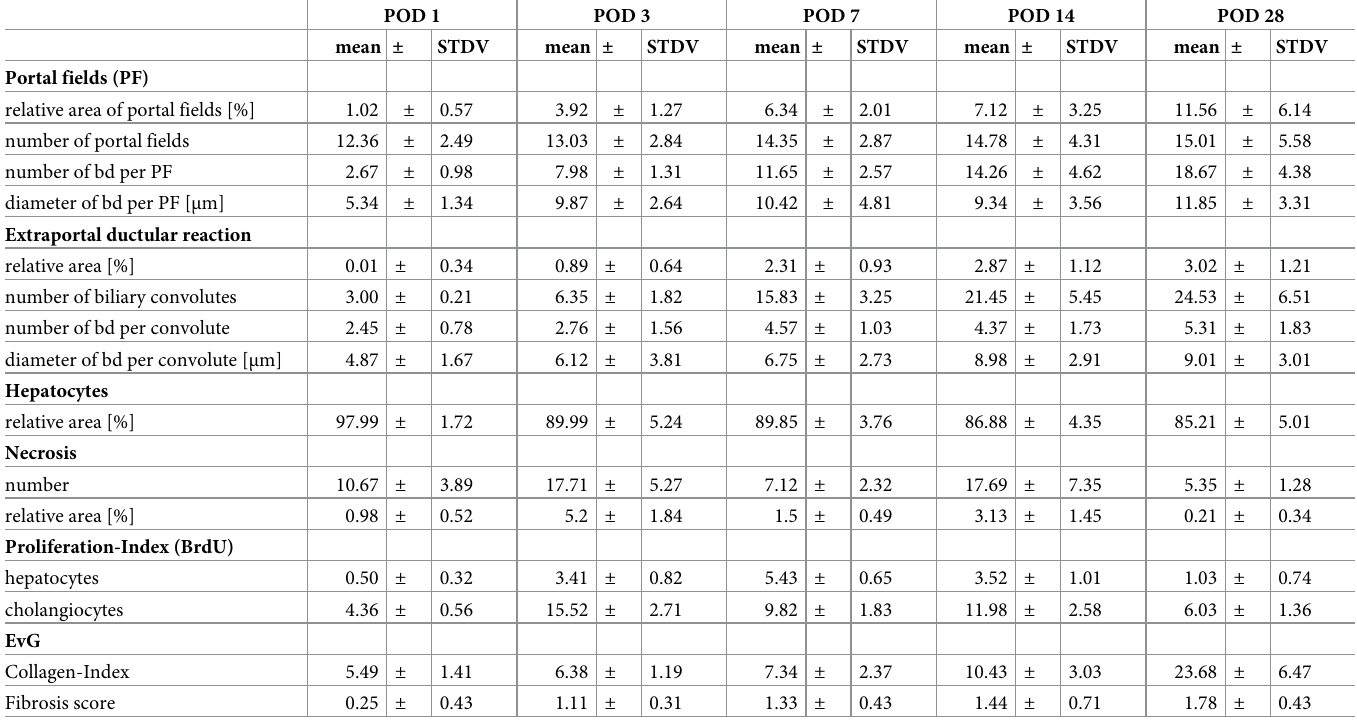
Table 5. Morphology and results of immunohistochemistry (HE, BrdU, EVG) after tBDT in mice.